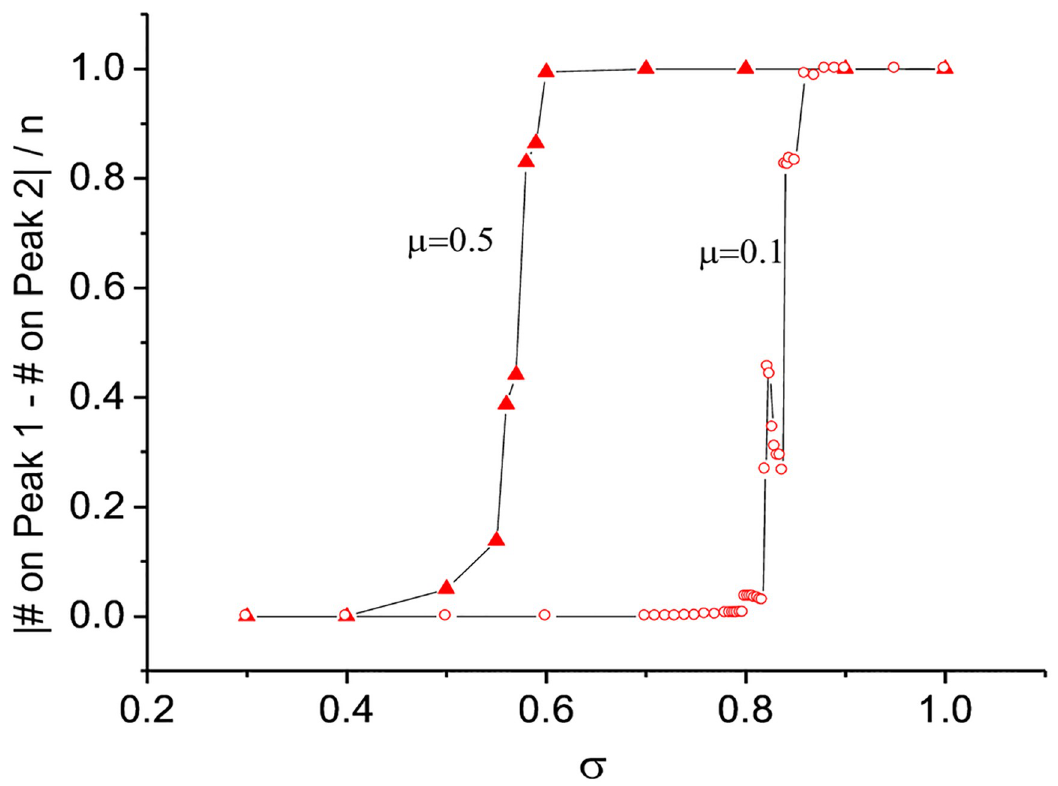
Fig 5. Transition to one-peak convergence. On the vertical axis, we report the absolute value of the difference between the number of individuals on one peak and the number of individuals on the other, divided by the entire number of individuals. If this ratio is 0, it means that the number of individuals on each peak is the same. For example, if 50 out of 100 individuals are on one peak and the other 50 are on the other peak, the value is |50–50|/100 = 0. As the ratio approaches 1, this means that there are more individuals on one peak than on the other. When the value is equal to 1 (i.e., |0–100|/100 = 1), all individuals are located only on one